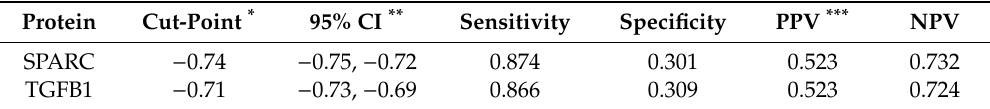
Table 4. Cut-point identification for biochemical recurrence (BCR) by protein marker.